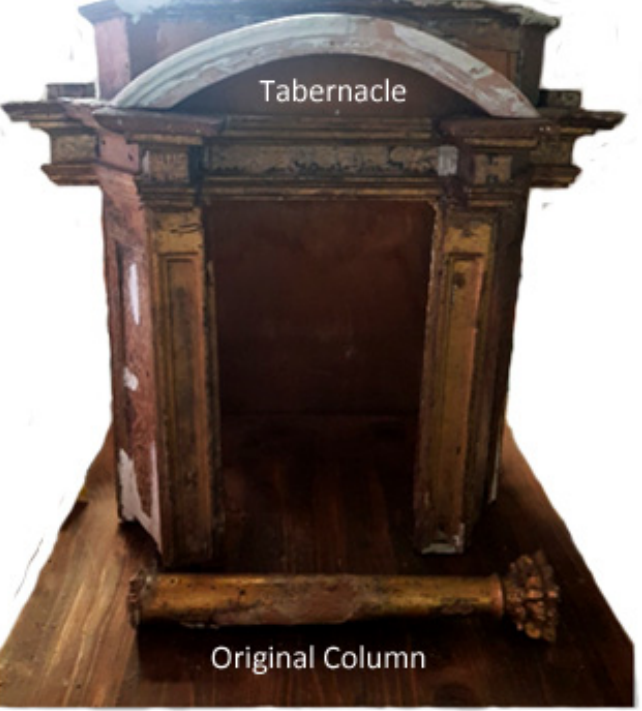
Figure 1. 17th-century polychrome wooden tabernacle and original